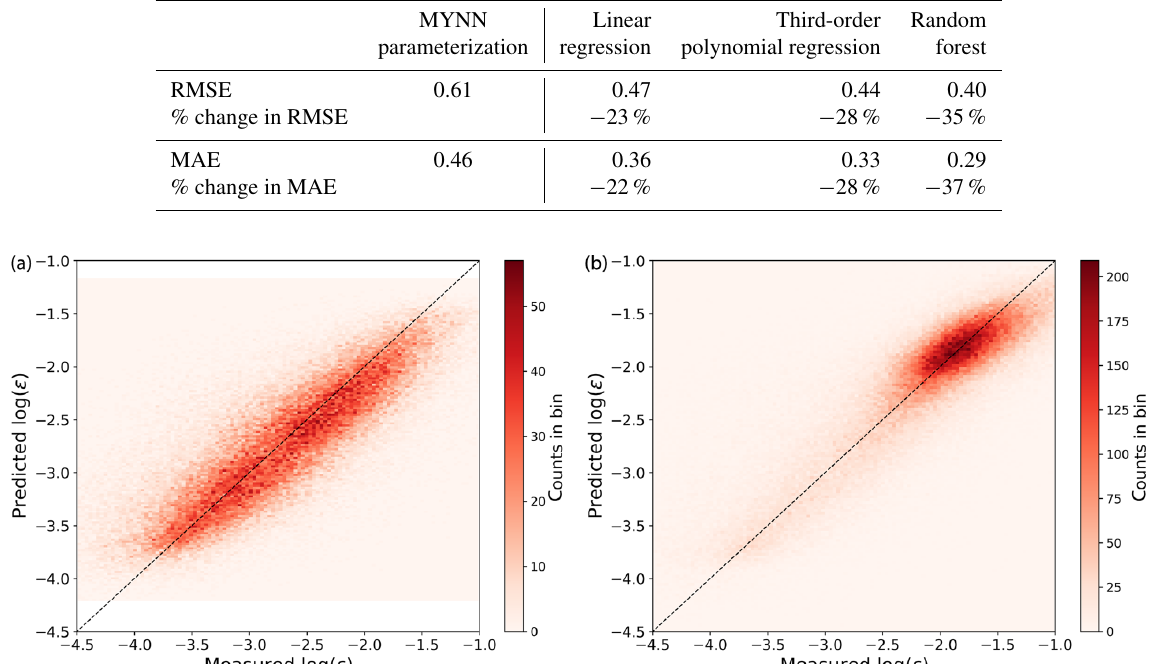
Figure 9. Scatter plot showing the comparison, performed on the testing set, between observed and machine-learning-predicted (cid:15) from a random forest for stable conditions (a) and unstable conditions (b)